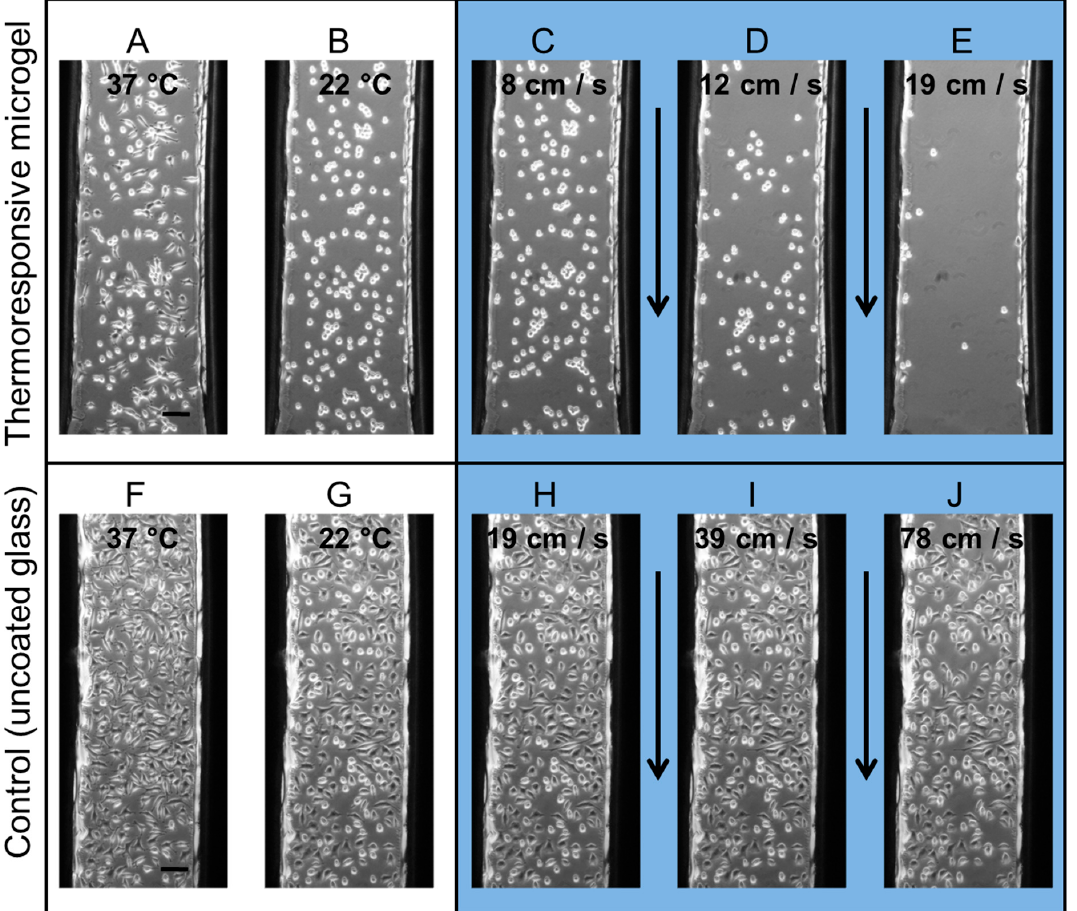
Figure 1. Phase contrast images of L929 mouse fibroblasts cultivated in a microchannel on a homogeneously microgel-coated glass substrate ( A – E ) and on an uncoated glass substrate (control) ( F – J ). The cells were cultivated one day in the microchannel at 37 °C ( A , F ). After having been exposed to room temperature (~22 °C) for 30 min ( B , G ), the microchannels were flushed using flows of stepwise increasing velocity (duration of 10 s for each step, the yellow arrow indicates the flow direction). The remaining cells in the microchannel at different flow velocities are shown at ( C ) 8 cm s − 1 , ( D ) 12 cm s − 1 , and ( E ) 19 cm s − 1 on a microgel-coated substrate, and ( H ) 19 cm s − 1 , ( I ) 39 cm s − 1 , and ( J ) 79 cm s − 1 on a glass substrate. Despite the high flow rates in the uncoated channels, the cells did not detach, although they were easily removed from the polymer coatings at low fluid velocities. Scale bars: 100 µm.